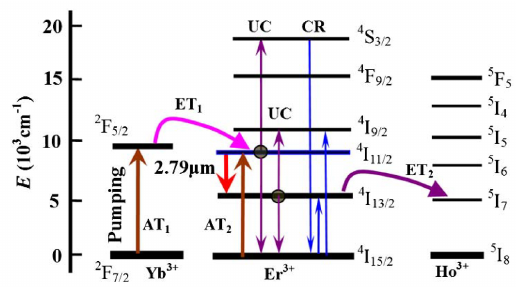
Figure 11. Energy transfer diagram among Yb 3+ , Er 3+ , and Ho 3+ ions [11].